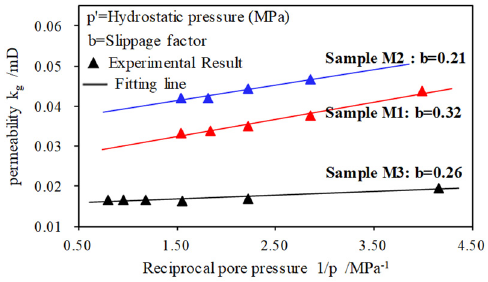
Figure 5. The fitting process of the slippage effect.